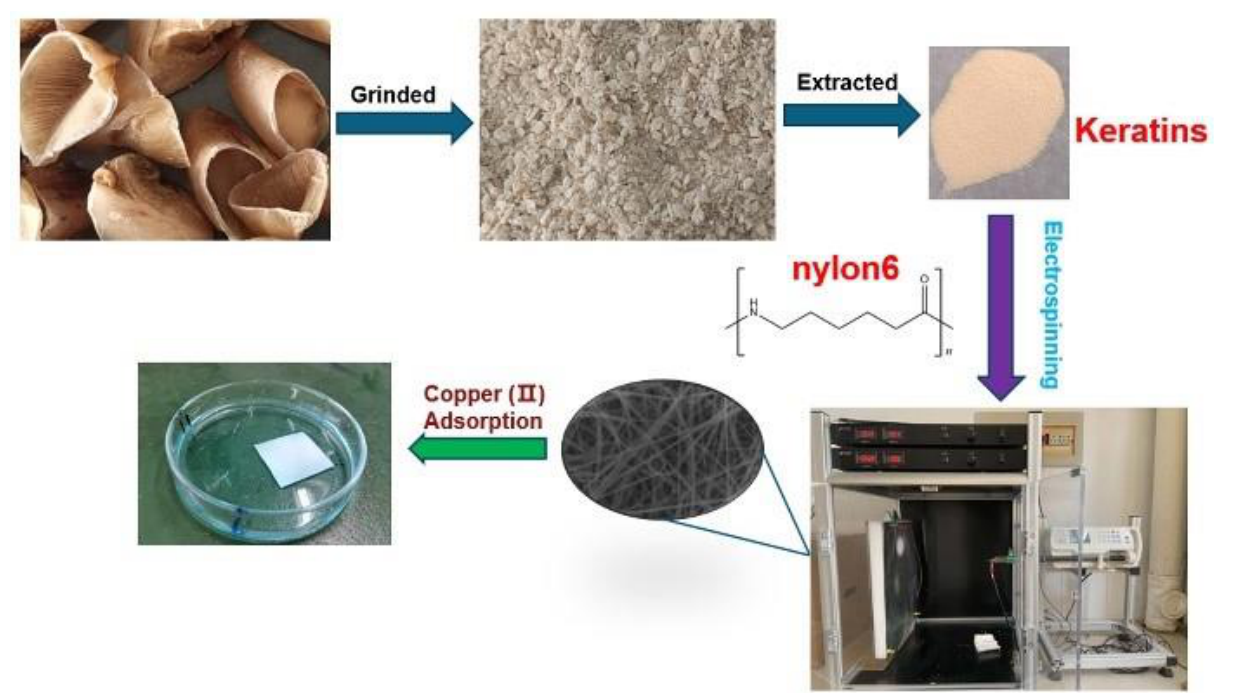
Figure 1. Schematic of the extraction of keratin from pig nails, the preparation of keratin/nylon6 nanofibers via electrospinning, and the application of the nanofiber membrane for the adsorption of copper (II).